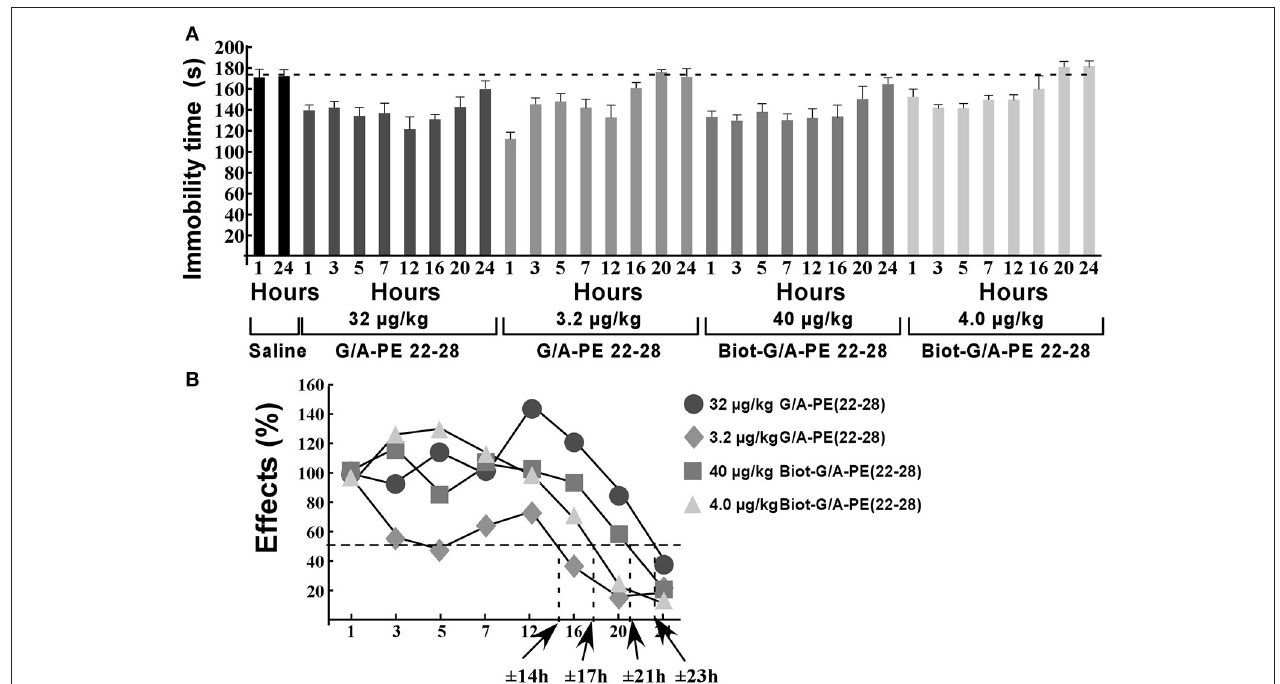
FIGURE 7 | Action duration of G/A-PE 22-28 and biotinylated-G/A-PE 22-28 measured by FST. (A) At each time-point, 10 naïve mice were tested for immobility in the FST. Saline injected mice were tested only at two times, 1 and 24 h. For each spadin-analog, at time 1h the difference between saline and spadin-analog treated mice was considered as 100%, Time-point immobility times were normalized to this 100% value. (B) Half-time effects were approximately of 14, 21, 17, and 23h for 3.2 µ g/kg of G/A-PE 22-28, 32 µ g/kg of G/A-PE 22-28, 4.0 µ g/kg of biotinylated-G/A-PE 22-28 and 40 µ g/kg of biotinylated-G/A-PE 22-28,